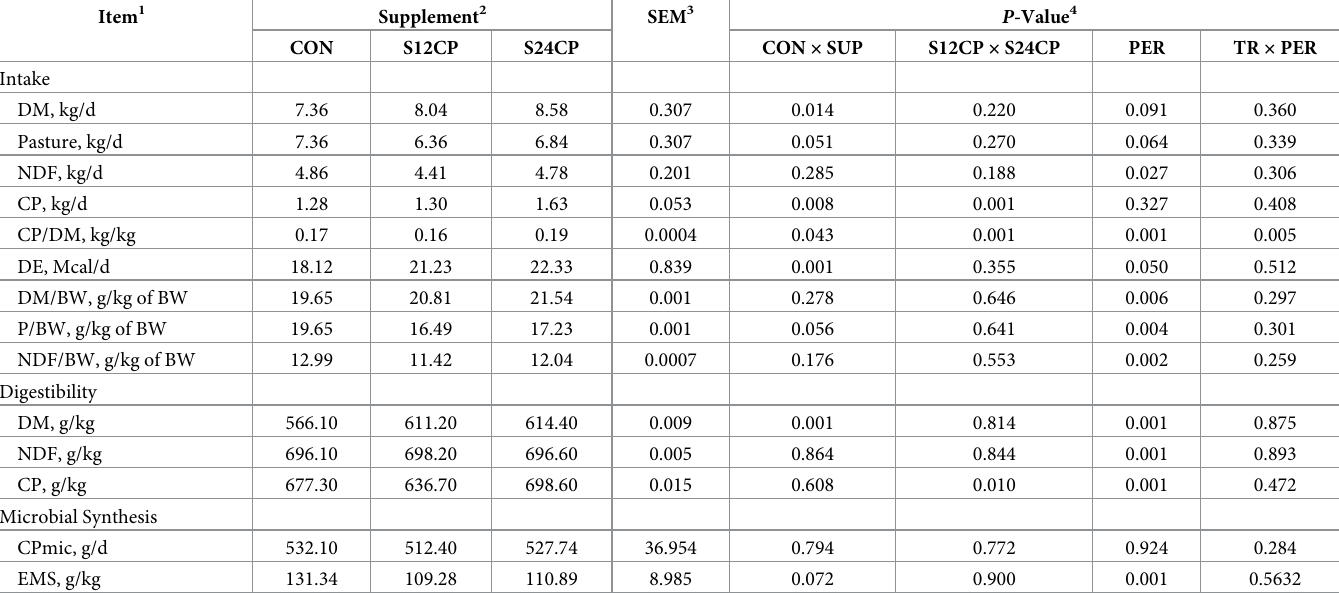
Table 3. Intake and diet digestibility of Holstein x Gyr crossbred heifers on a rotational grazing system Panicum maximum cv. Mombac¸a